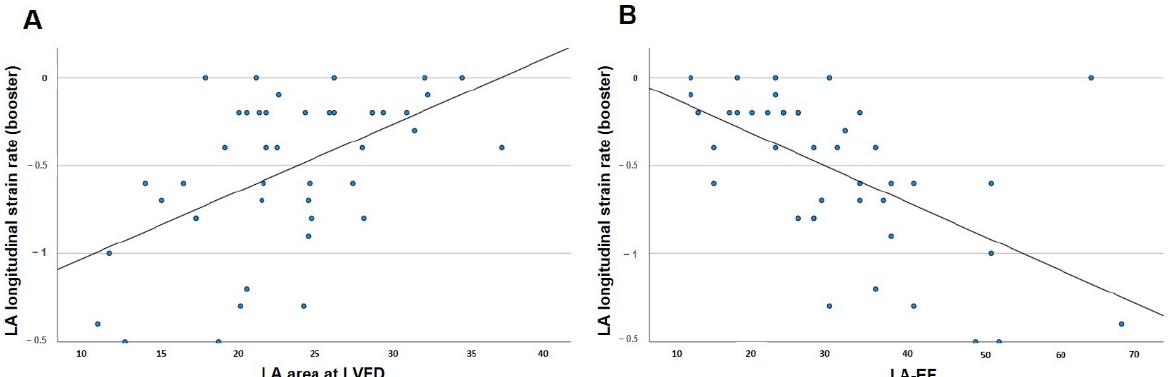
Figure 5. Pearson’s correlation for left atrial booster strain rate and disease-relevant factors in cardiac amyloidosis. ( A ) Correlation of left atrial booster strain rate and end-diastolic left atrial area. ( B ) Correlation of left atrial booster strain rate and left atrial ejection fraction. LA-EF: left atrial ejection fraction; LV-EF: left ventricular ejection fraction; LA: left atrial; LV: left ventricular; LVED: left ventricular end diastole.